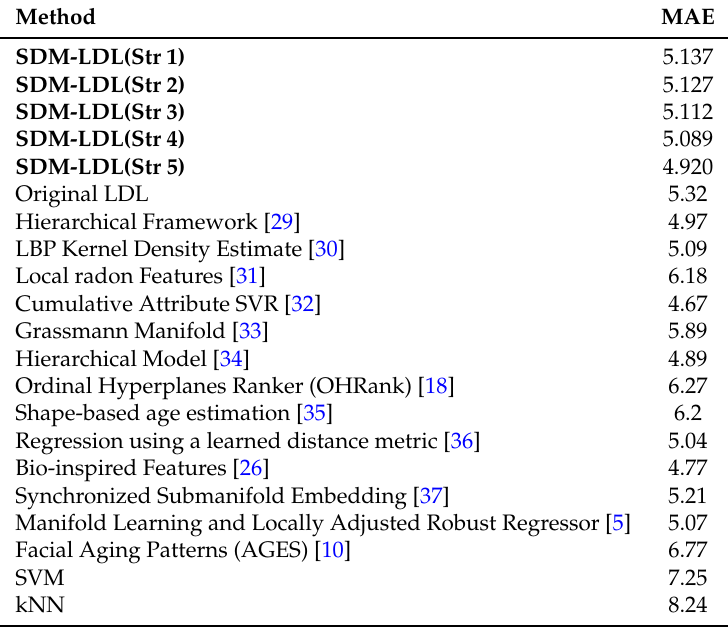
Table 11. MAEs of different facial age estimation